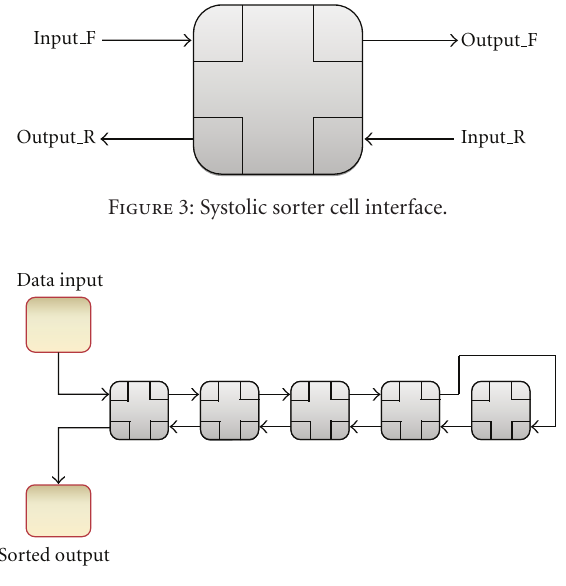
Figure 4: Systolic sorter array